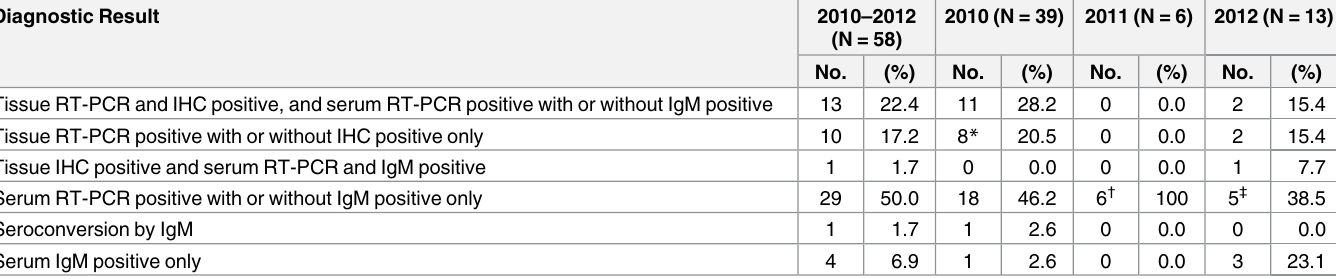
* Three were dual infections; two had DENV and Leptospira spp . bacteria identified and one had DENV and Streptococcus pneumonia identified in tissue. † One dual infection with DENV and Leptospira spp . bacteria identified. ‡ One dual infection with DENV and Leptospira spp . bacteria identified.